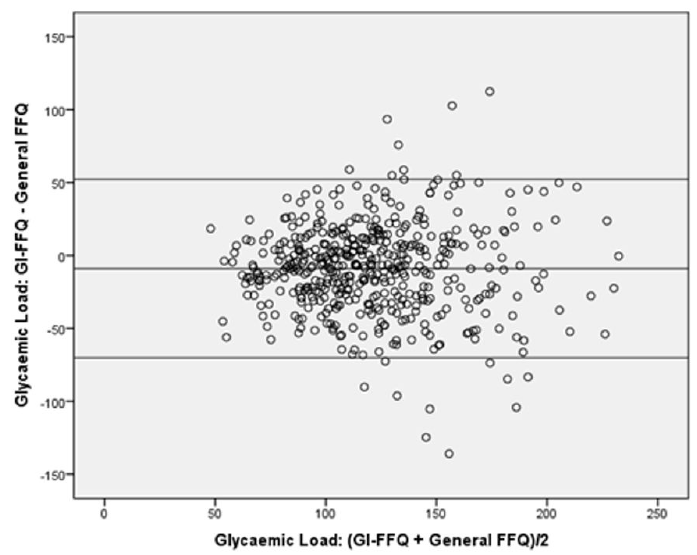
Figure 2. Bland-Altman plot for glycaemic load showing the relative validity of the GI-FFQ versus the general-FFQ. Middle line indicates the mean; upper and lower lines indicate borders based on mean ± SD × 1.96 (i.e., − 9.0+/ −